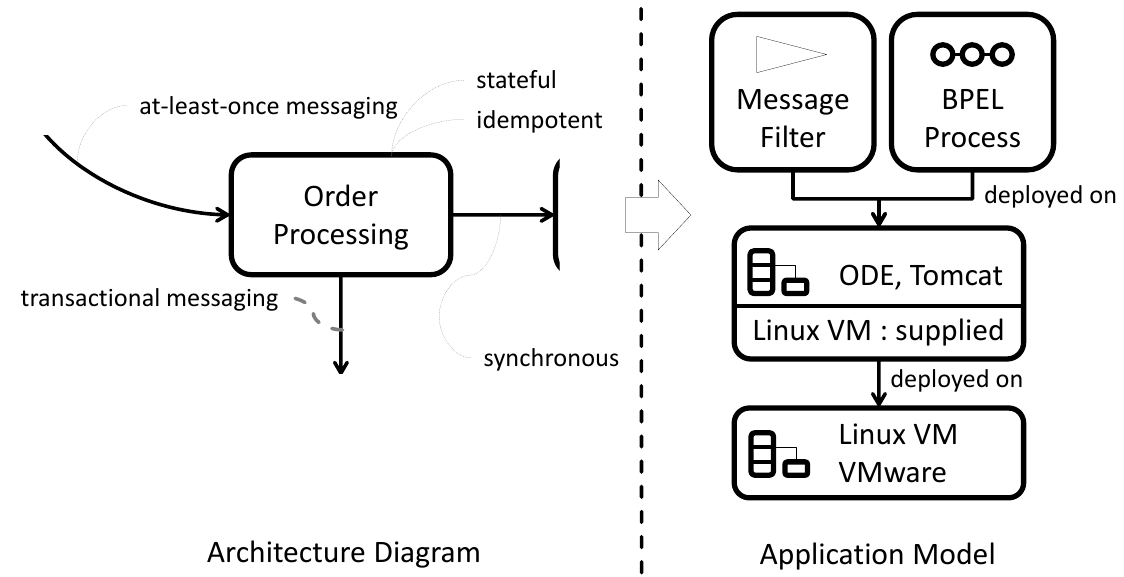
Figure 20. Concretization of the Order Processing